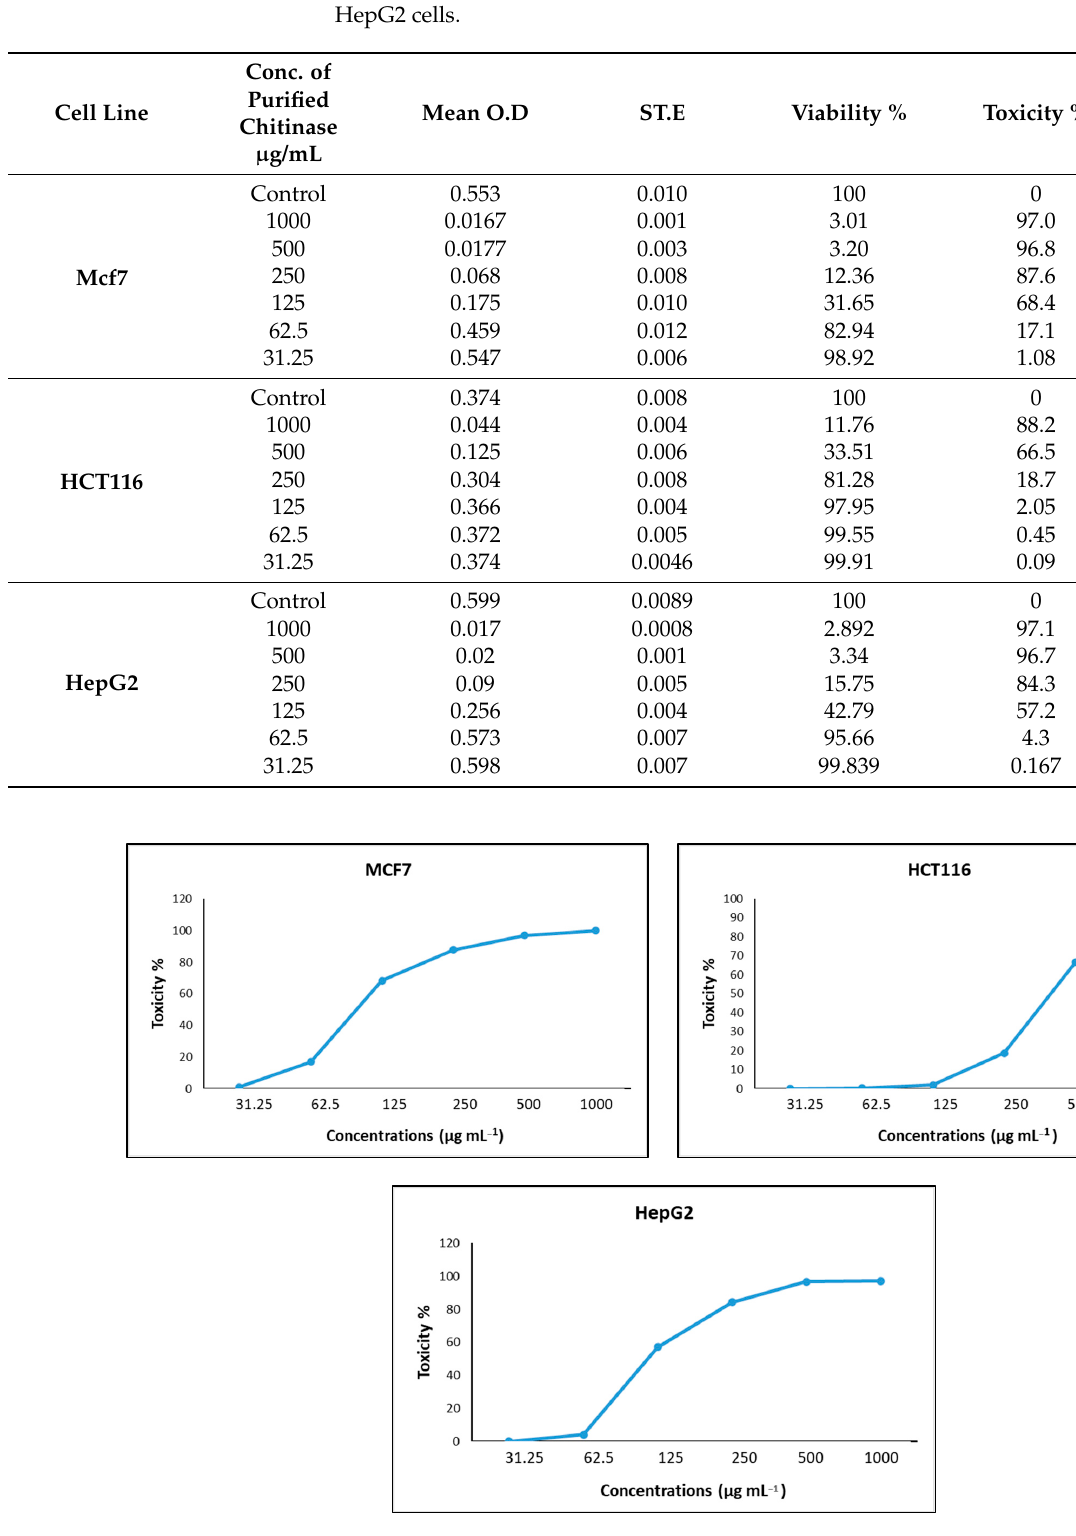
Figure 12. Effect of purified chitinase by T. funiculosus strain CBS 129594 on MCF7, HCT16, and HepG2 cells at different concentrations.